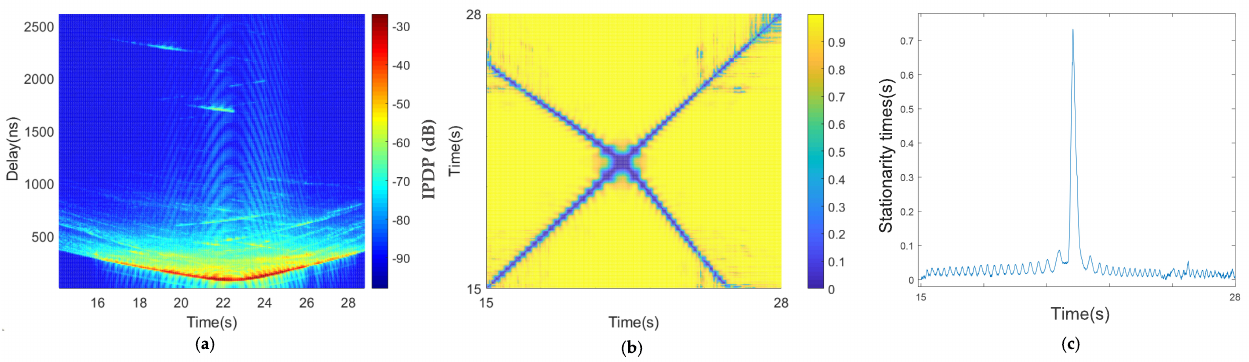
Figure 12. Results of the suburban intersection scenario: ( a ) average PDPs, ( b ) temporal PDP correlation coefficient, and ( c ) stationarity time